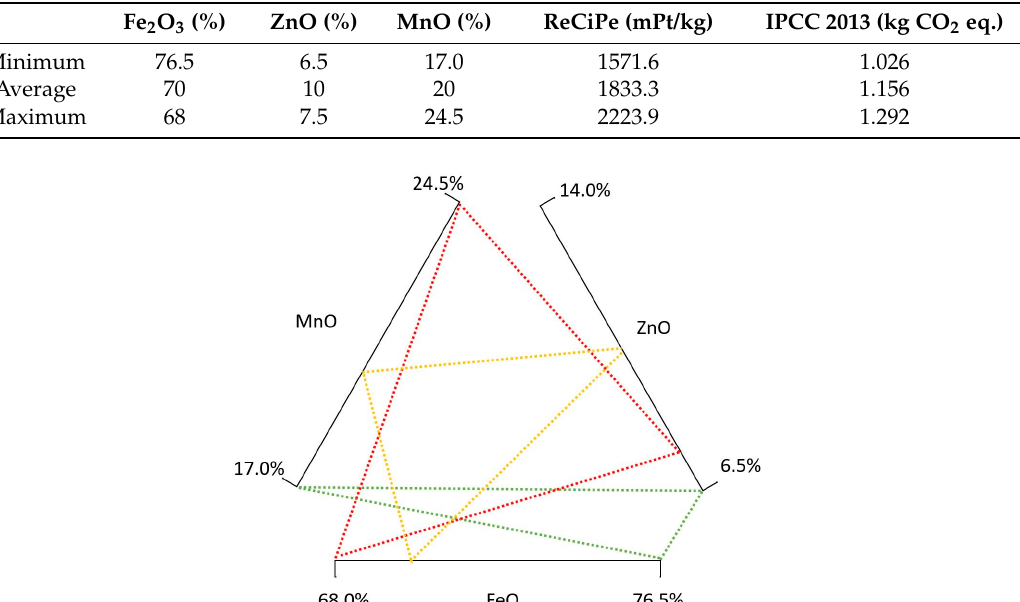
Table 8. Minimum, maximum, and average environmental impact of 1 kg MnZn soft ferrite (RMA + Production).